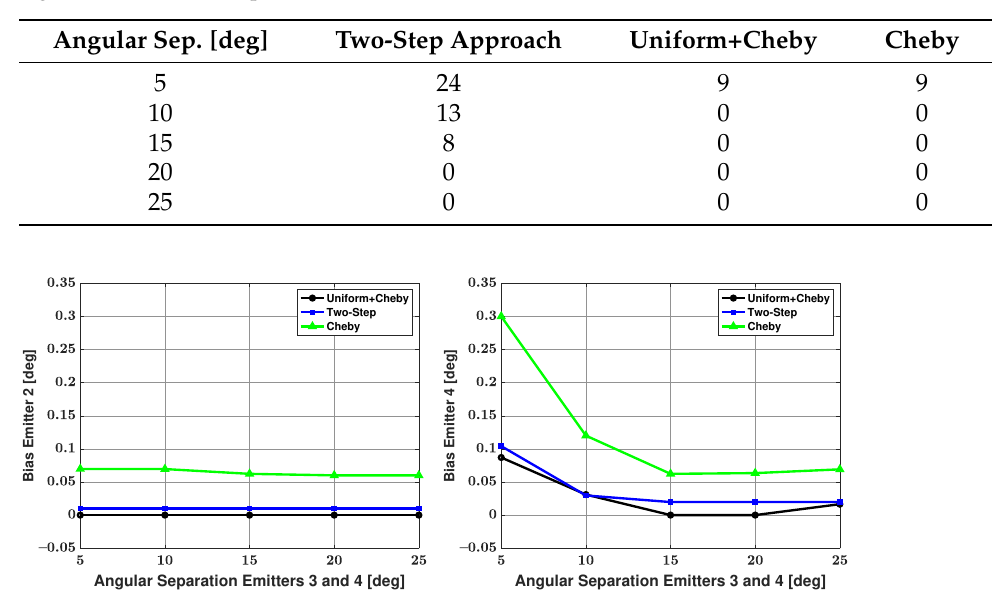
Table 3. Number of failures in 500 trials with respect to angular separation for the four-signal scenario. The SNR of signal 1 = 18 dB, the SNR of signal 2 = 5 dB, the SNR of signal 3 = 25 dB, the SNR of Signal 4 = 0 dB, 100 snapshots, and 500 trials.